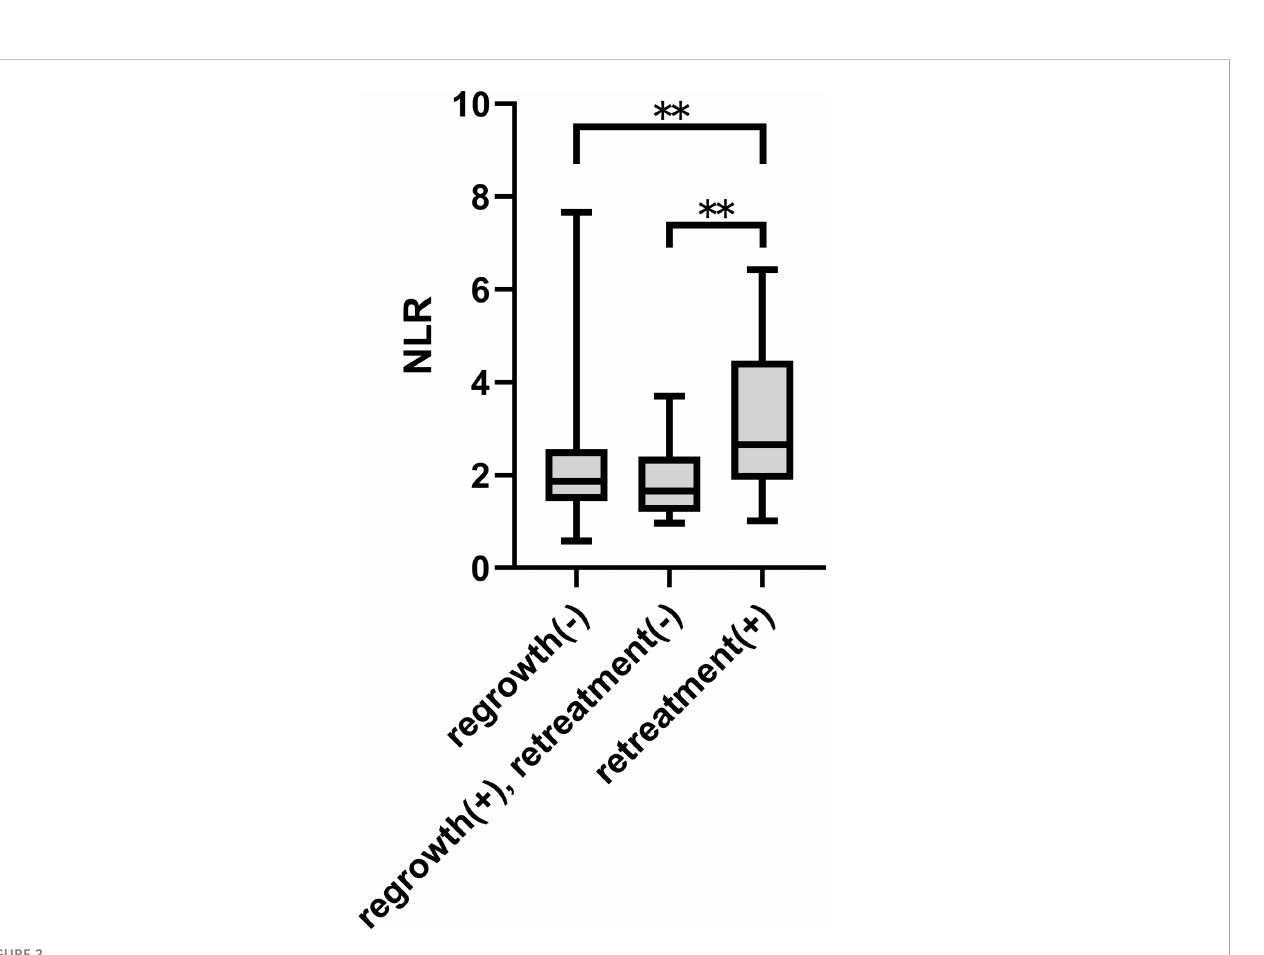
FIGURE 2 NLR value according to postoperative outcome **p <